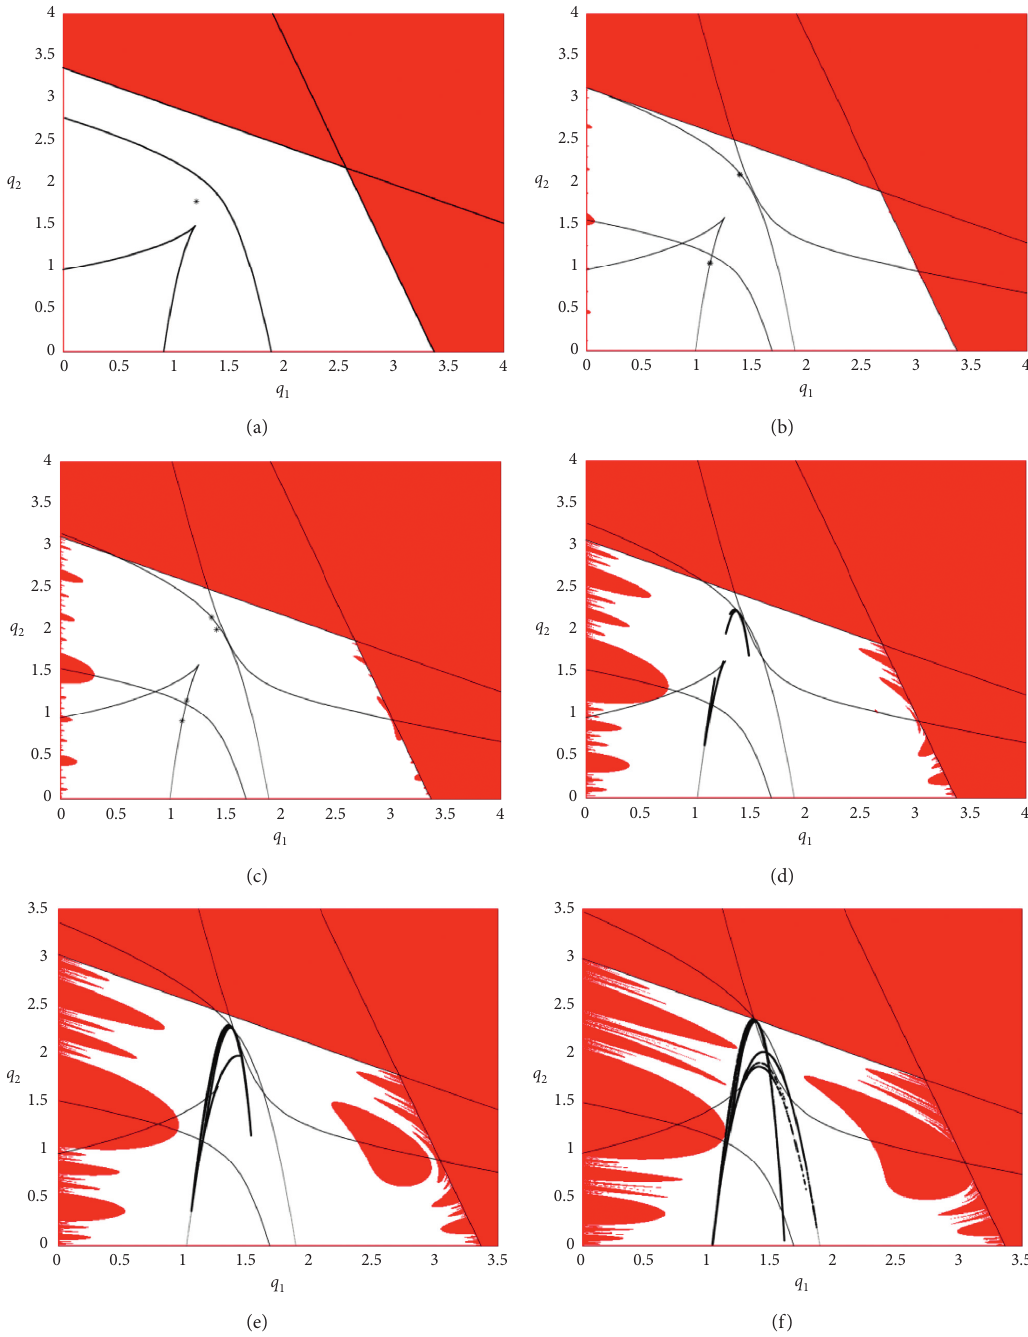
Figure 5: The evolution of the attractor and its attracting basin, where the parameters are fixed as a � 4 . 69976212, b � 0 . 92281351, � 0 . 066, α � 0 . 621, c � 0 . 36680549, and v α 1 2 � 0 . (f) v 2